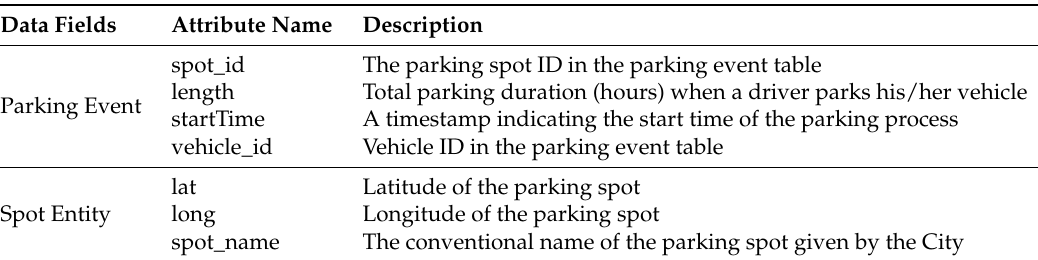
Table 3. The description of data